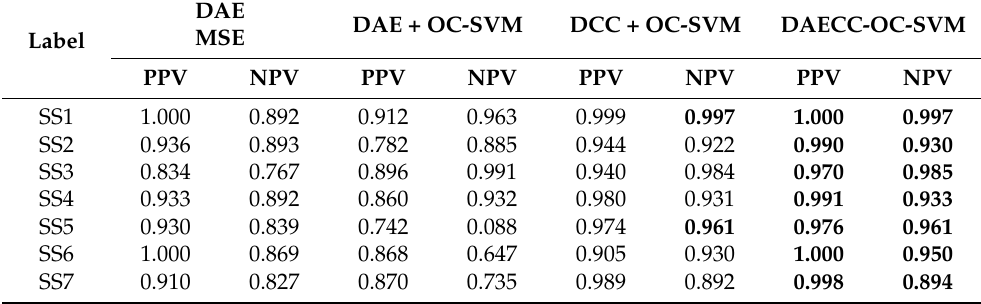
Table 8. Comparison of performance of anomaly detection in terms of TPR and TNR on CWRU